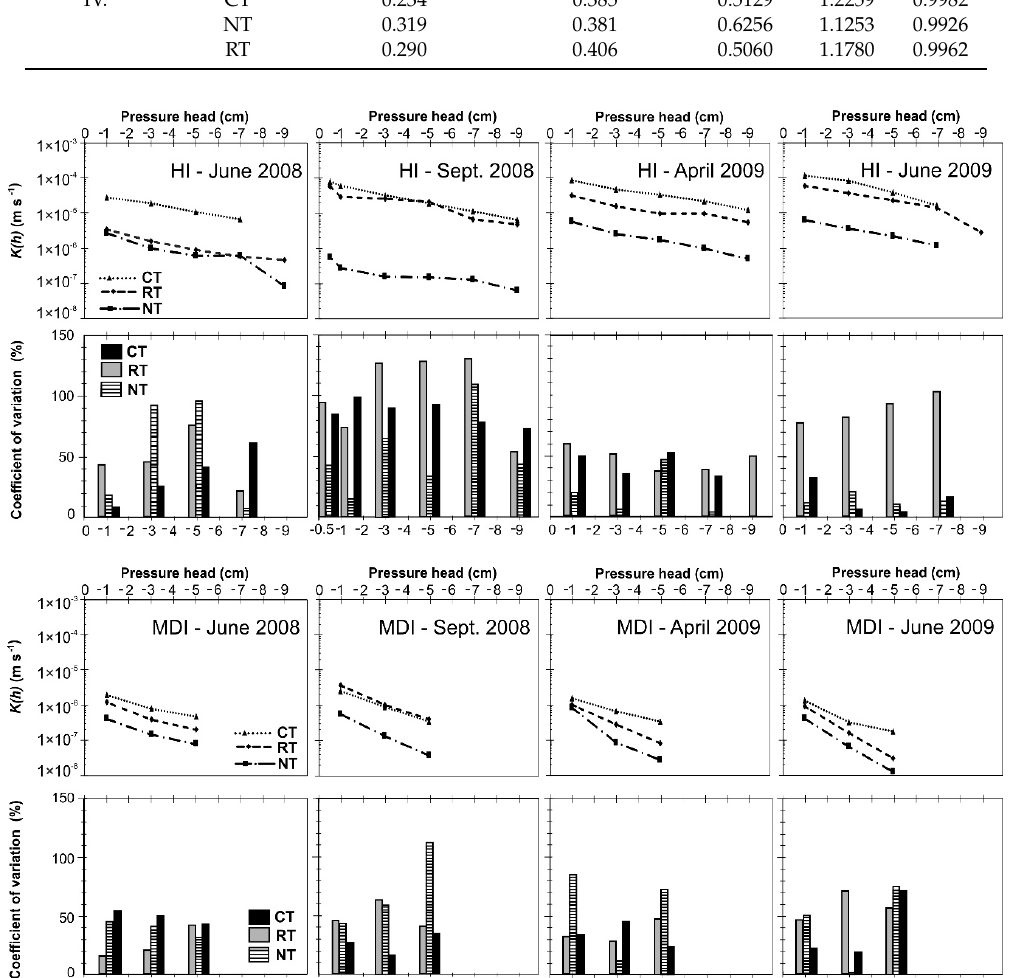
Figure 2. Comparison of K ( h ) data determined by Hood infiltrometer (HI) and MDI by analytical solutions suggested in the most up to date manuals.